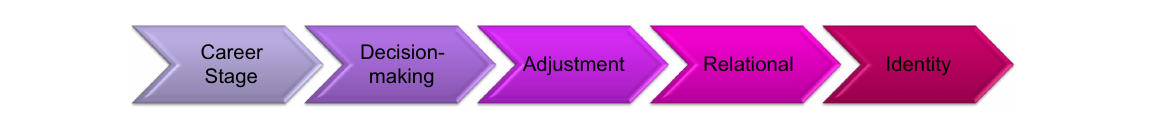
FIGURE 2 Five major theoretical perspectives of career transitions. While career stage perspectives can be fairly predictable events, transitions may occur as an individual ages and moves from one period of development to another across their career. Research has looked closely at what factors